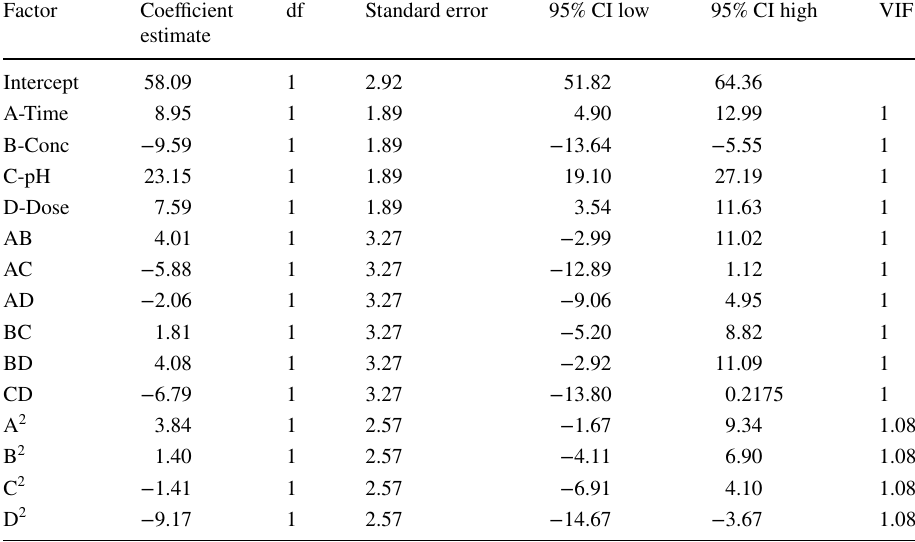
Table 4 Coefficients